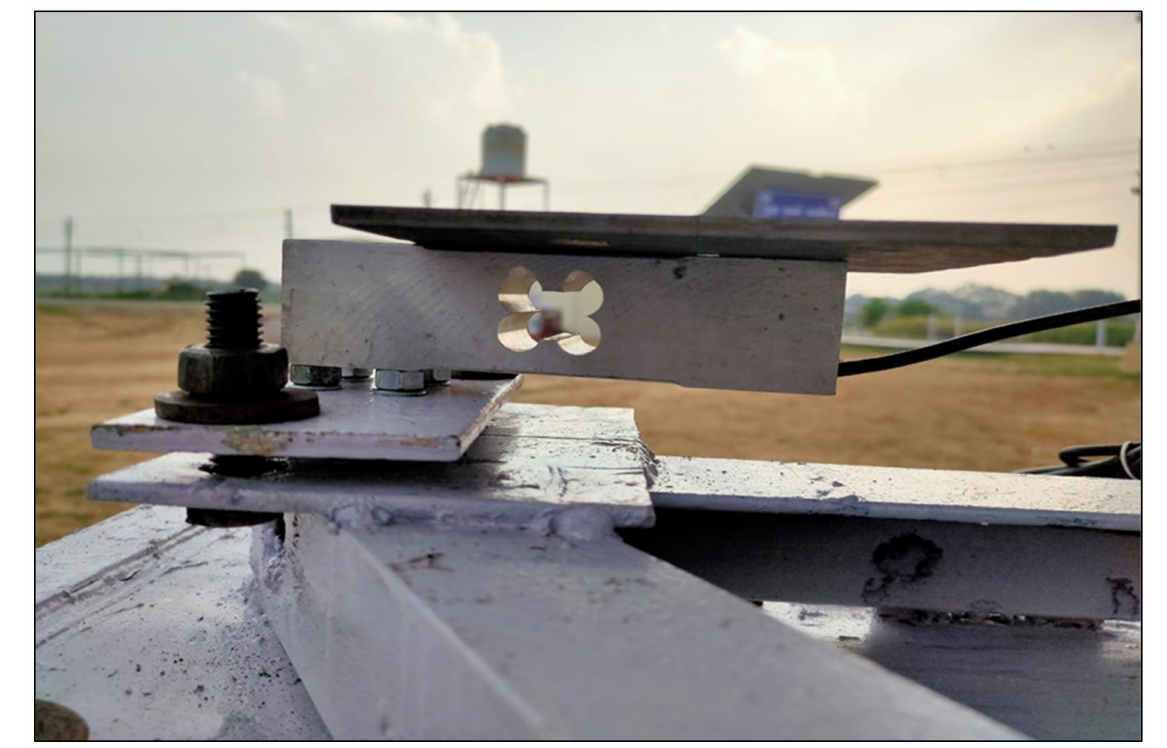
Figure 8. Arrangement of loadcell assembly at bottom structure of the